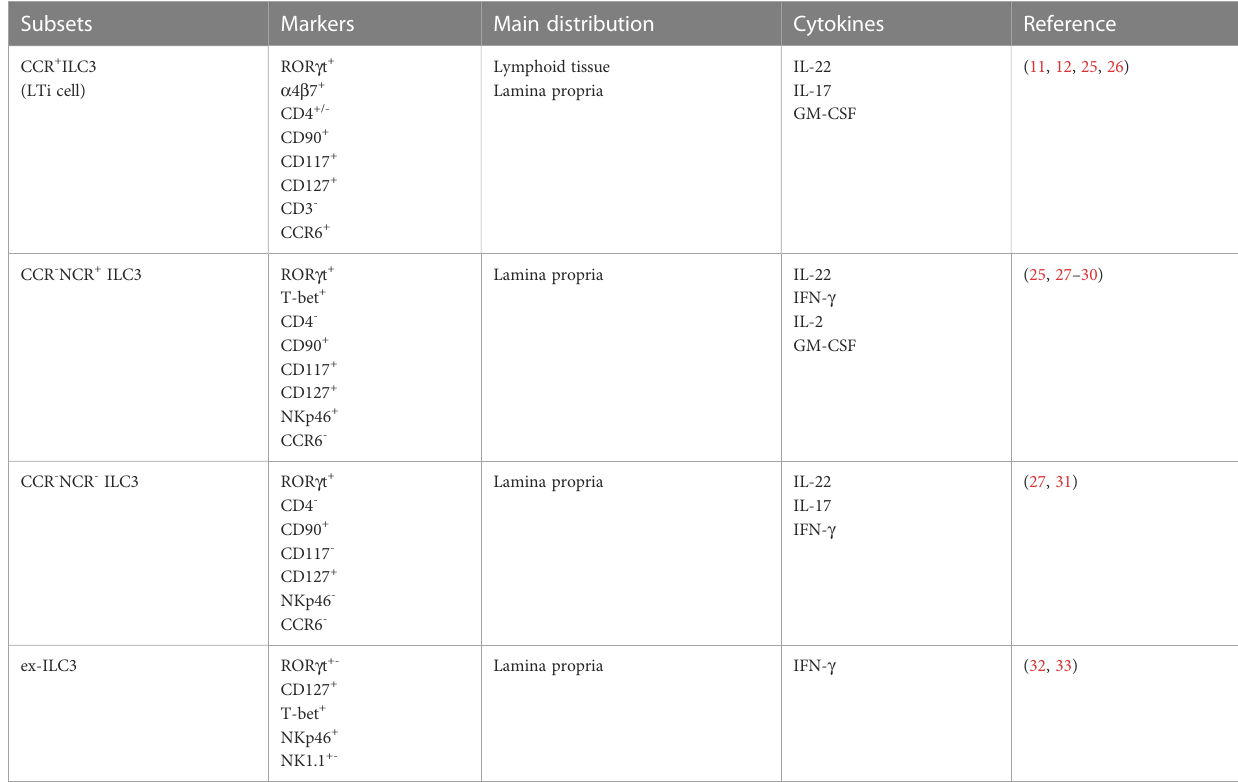
TABLE 1 The subsets of ILC3 in mouse